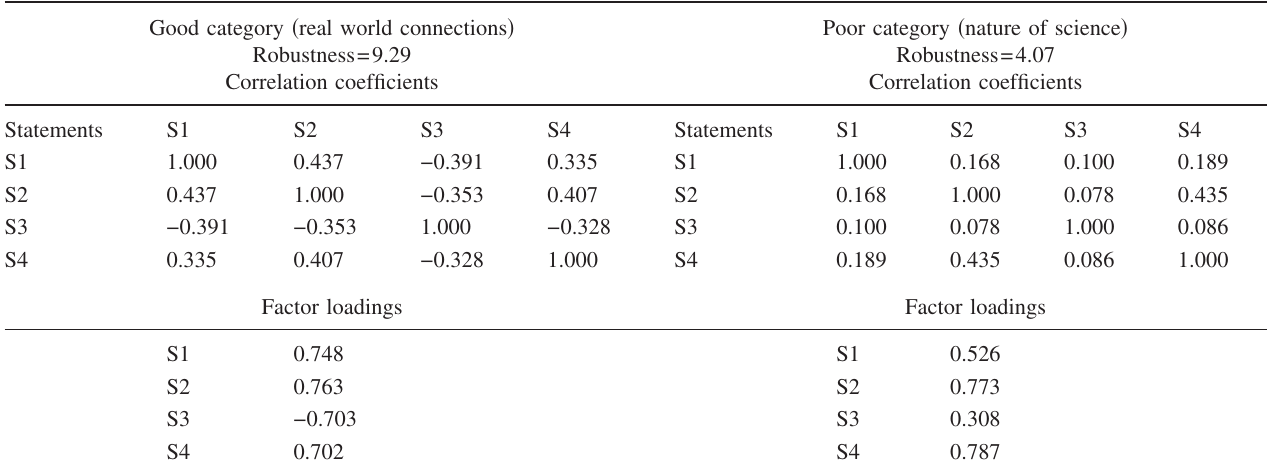
TABLE IV. Category robustness ratings. These data are from an analysis of a combined data set of responses from students in algebra-based physics and students in physics for nonscience majors. Note that the signs are irrelevant to the statistical analysis, as explained in the text.